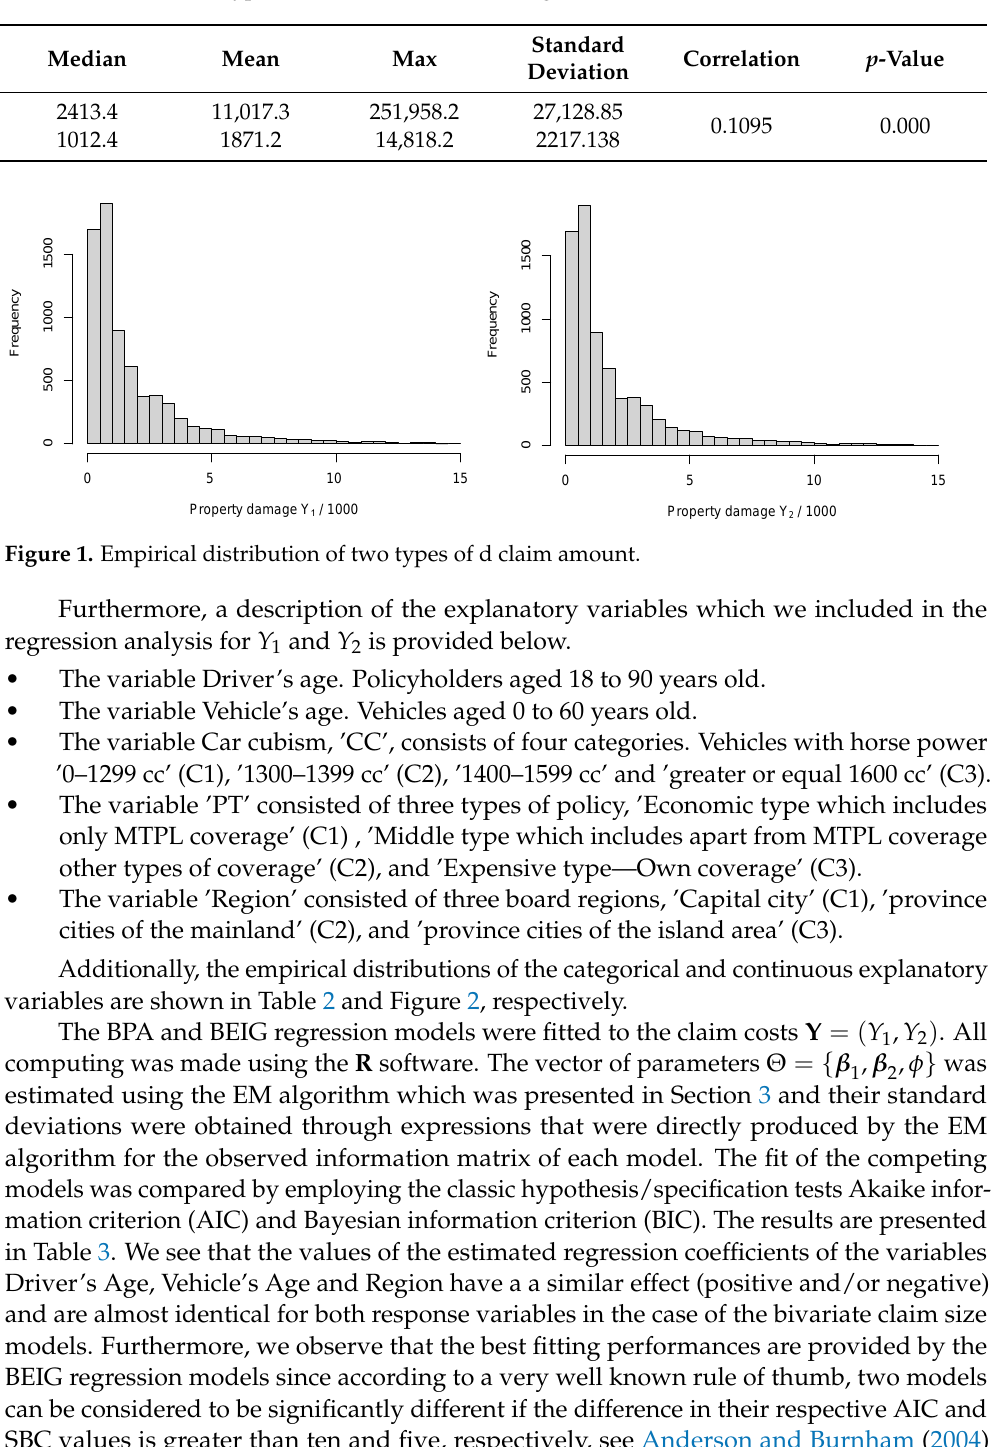
Table 1. Summary statistics of two types of d claim amount. The correlation test is an one-sided test, where the alternative hypothesis is ’true correlation is greater than 0’.